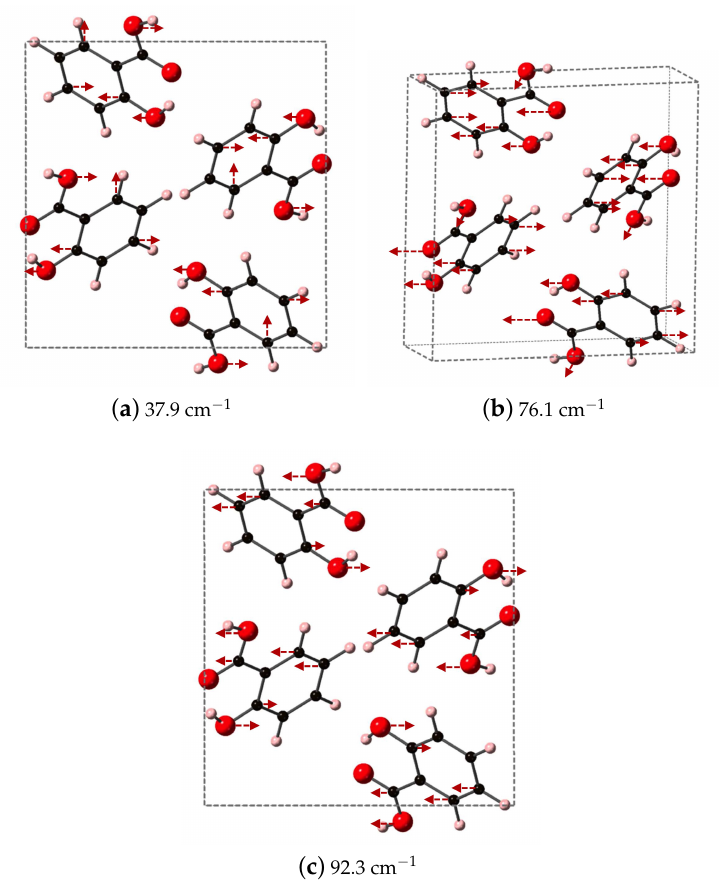
Figure 7. Shown here are the DFT-D computed IR active modes of SA that occur at ( a ) 37.9 cm − 1 (along y ); ( b ) 76.1 − 1 (along xz ); and ( c ) 92.3 − 1 (along y